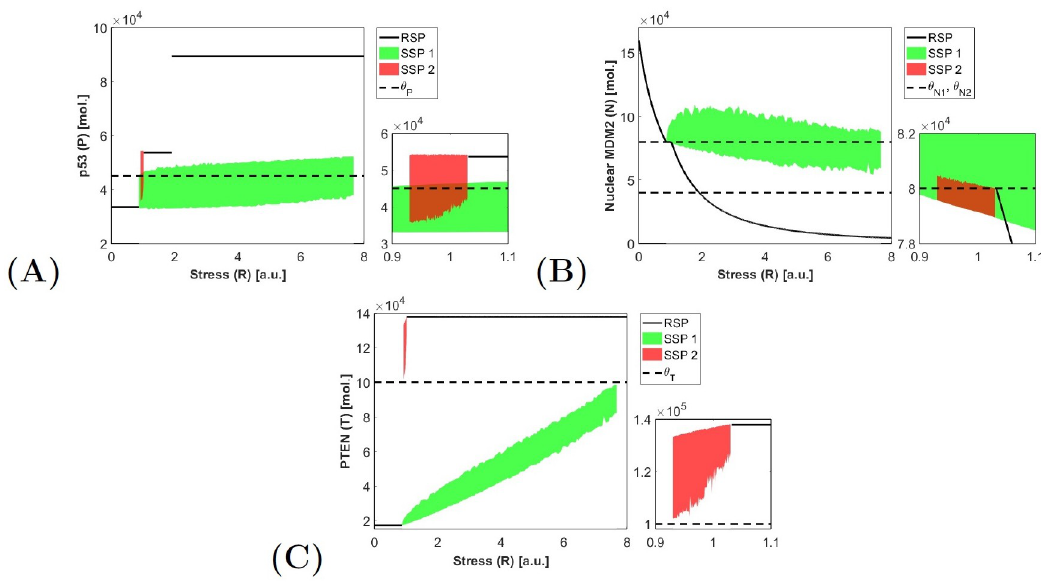
Fig 6. Bifurcation diagrams of protein levels for different stress level. A: Bifurcation diagram for p53 ( P ); B: Bifurcation diagram for MDM2 ( N ); C: Bifurcation diagram for PTEN ( T ). On the right side of the main panels we show the magnification for R = (0.9, 1.1) a . u